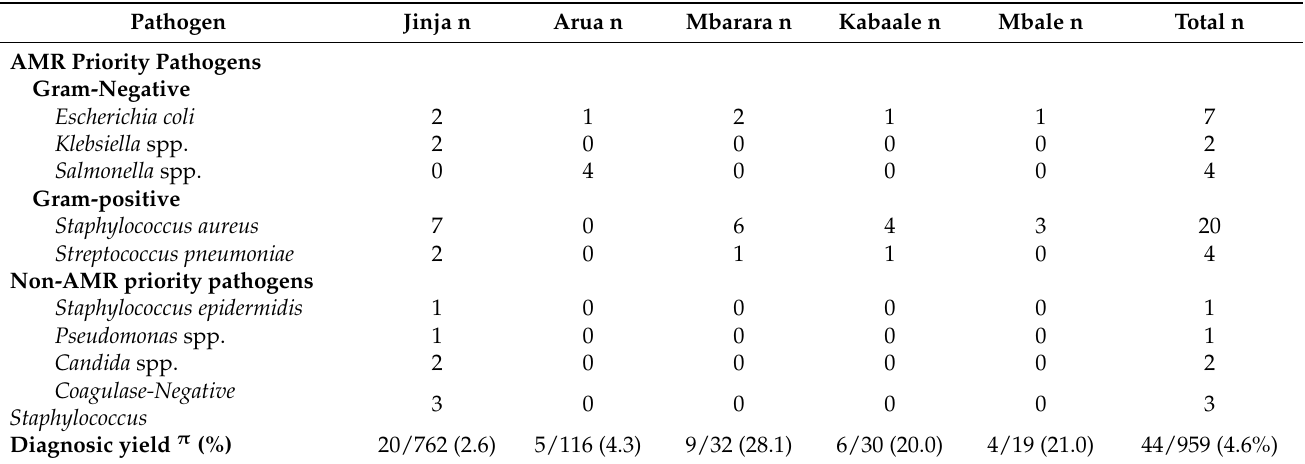
Table 3. Identified pathogens and yield among hospitalized/non-malarial febrile children undergoing blood culture at five antimicrobial resistance surveillance sites in Uganda, October 2017–September 2018.